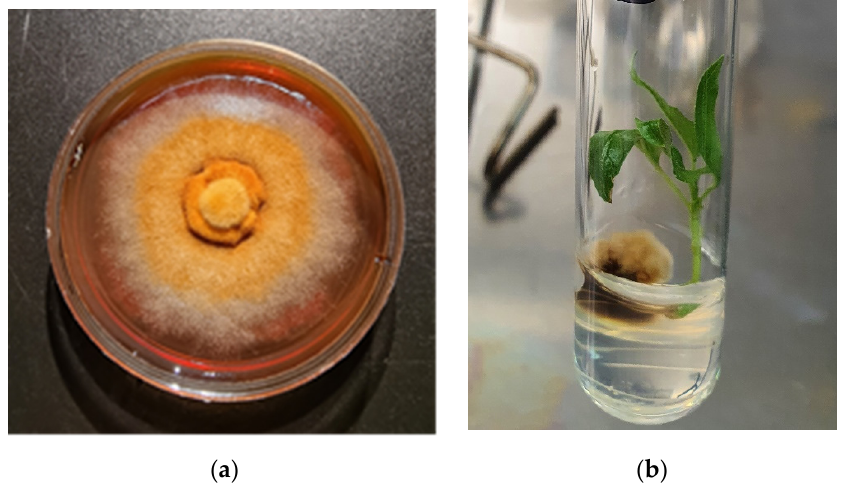
Figure 3. Fungus P. tremulae : ( a ) in a pure culture on malt nutrient medium; ( b ) with a Populus microshoot post inoculation.